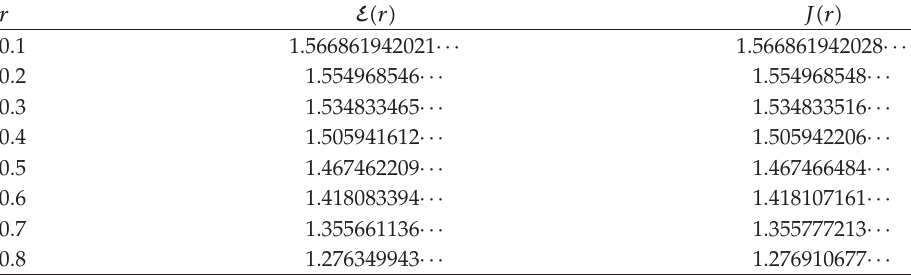
Table 2: Comparison of E (cid:2) r (cid:3) with J (cid:2) r (cid:3) for some r ∈ (cid:2) 0 , 1 (cid:3)